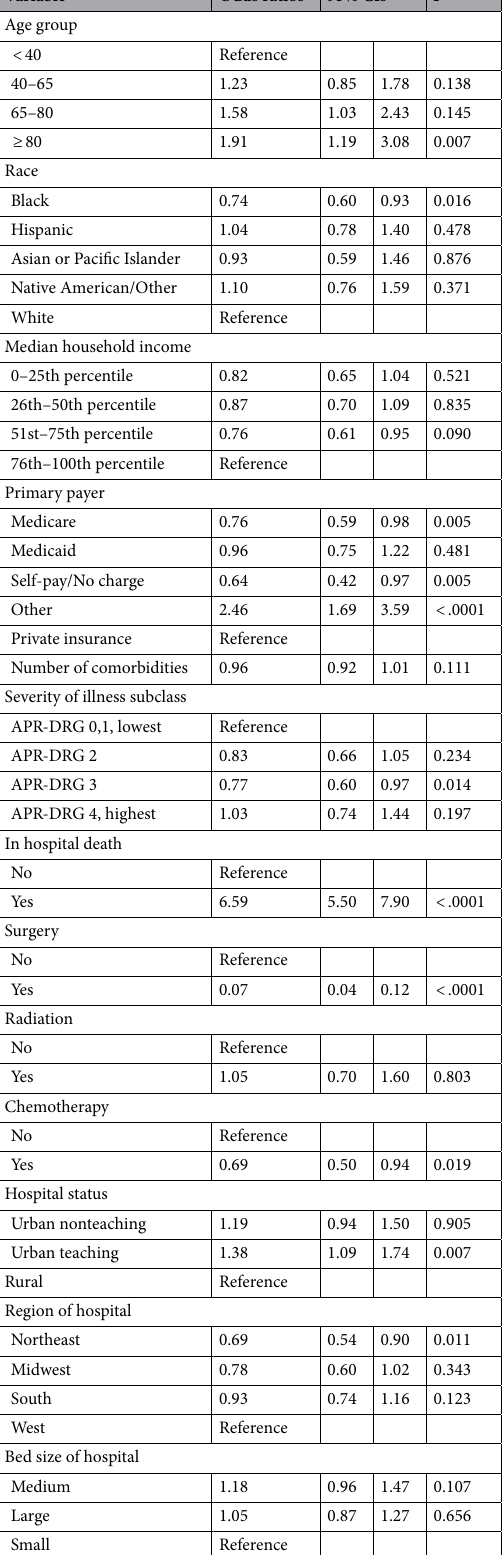
Table 2. Results of Survey Logistic Regression: Odds of receiving palliative